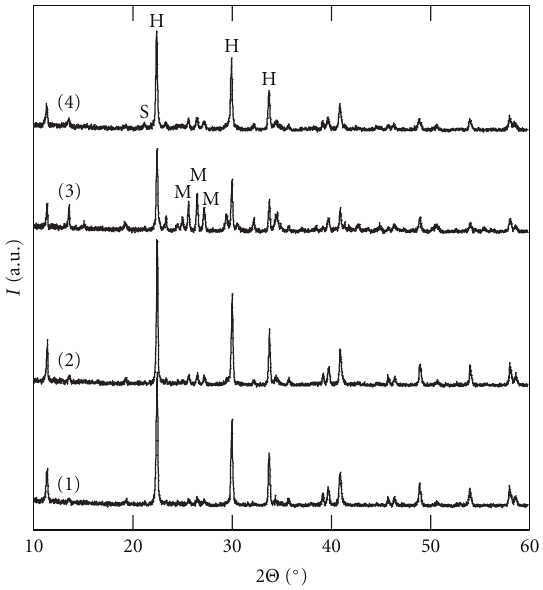
Figure 2: XRD patterns of powder-like samples 1, 2, 3, and 4 thermally treated at 1000 ◦ C for 5 hours (M = monoclinic celsian, H = hexacelsian, S = sodium